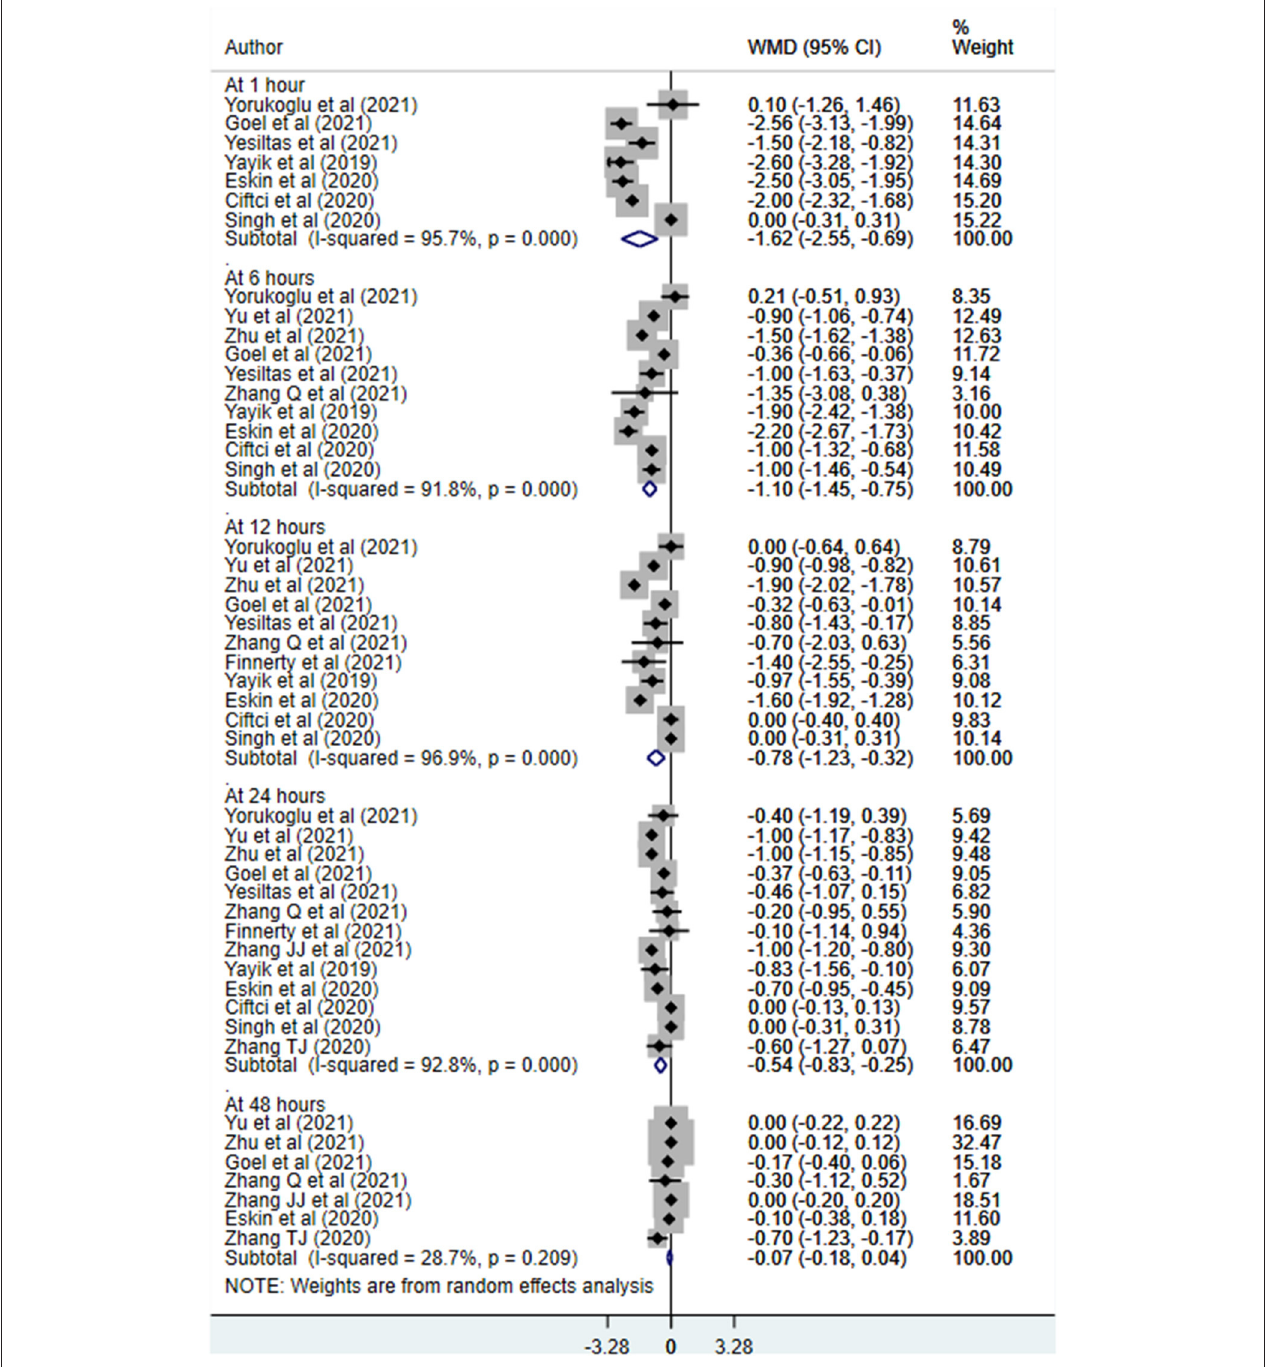
FIGURE 4 | Postoperative pain scores at rest among subjects with erector spinae plane block, compared to placebo or no block.